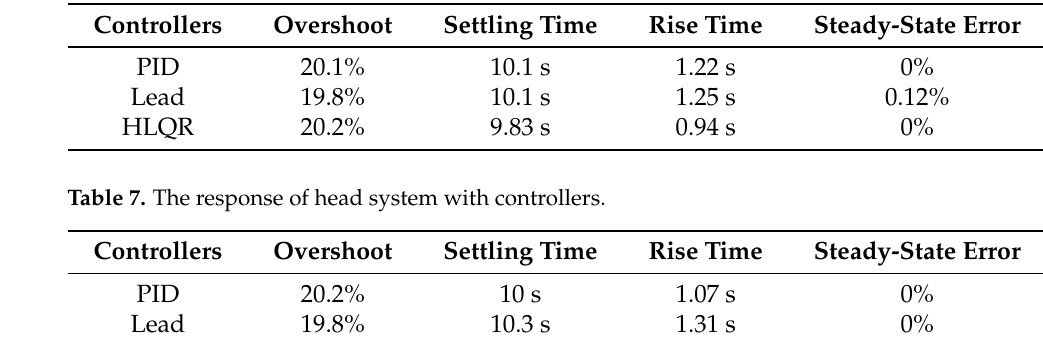
Table 6. The response of pitch system with controllers.